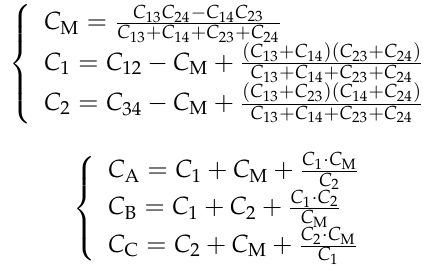
Figure 2. Coupling structure and equivalent model. ( a ) Front view of integrated electromagnetic coupler. ( b ) Equivalent model of integrated electromagnetic coupler.